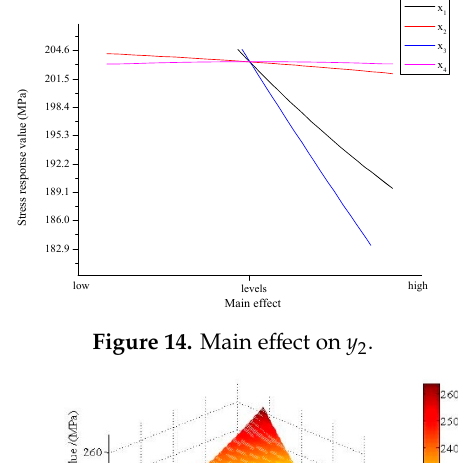
Figure 13. Pareto diagram on y 2 .